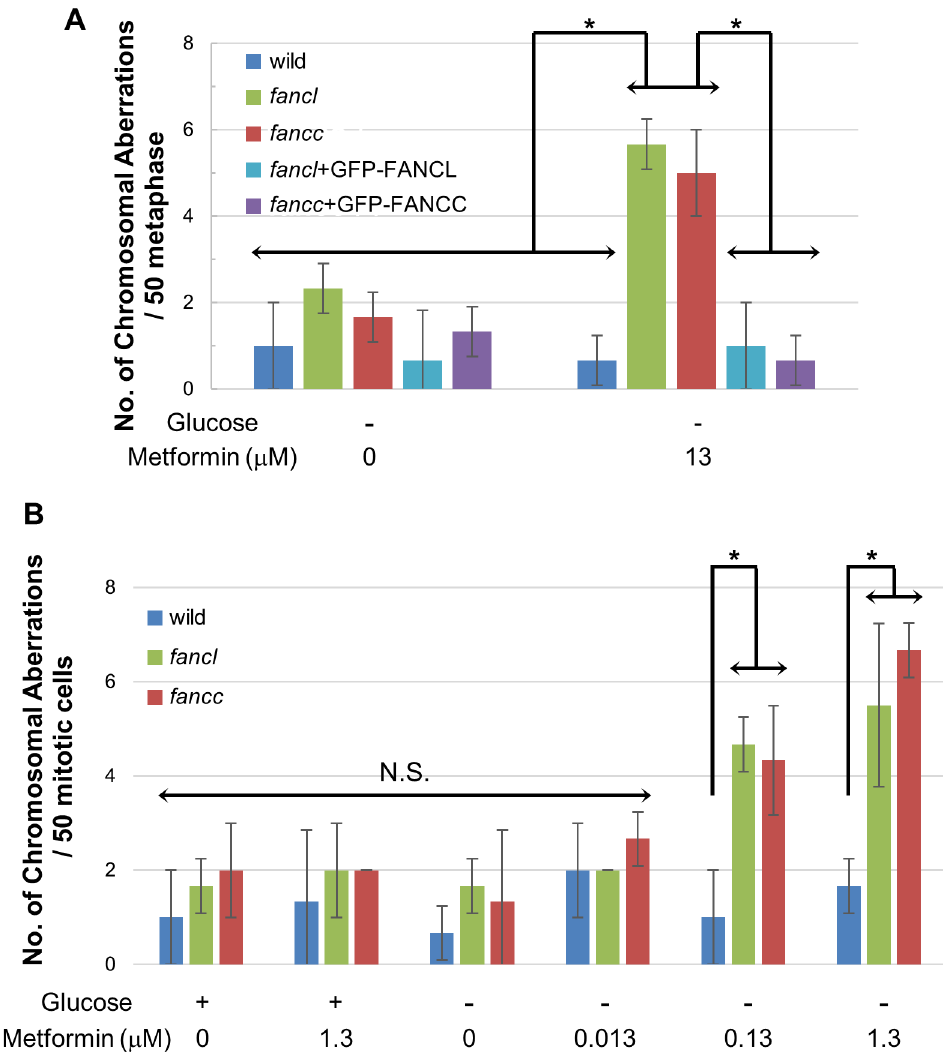
Fig 3. Induction of chromosomal breakagesby metformin under glucose-depleted conditions. (A) Wild-type cells, cell lines deficient in FANCC or FANCL, and reconstituted cells were incubatedwith or without 13 μ M metformin for 24 h under glucose-depletedconditions; (B) Wild-type cells and cell lines deficientin FANCC or FANCL were incubatedwith the indicateddoses of metformin for 24 h in glucose-depleted or -containingmedium. We analyzed50 metaphasenuclei, and quantified the number of chromosomal aberrations per cell (Y-axis). Data representthe mean ± S.E. Asterisks ( * ) indicate p < 0.05 by a multiple comparisonone-wayANOVA (Tukey’s test). N.S.: not significant( p (cid:21) 0.05).